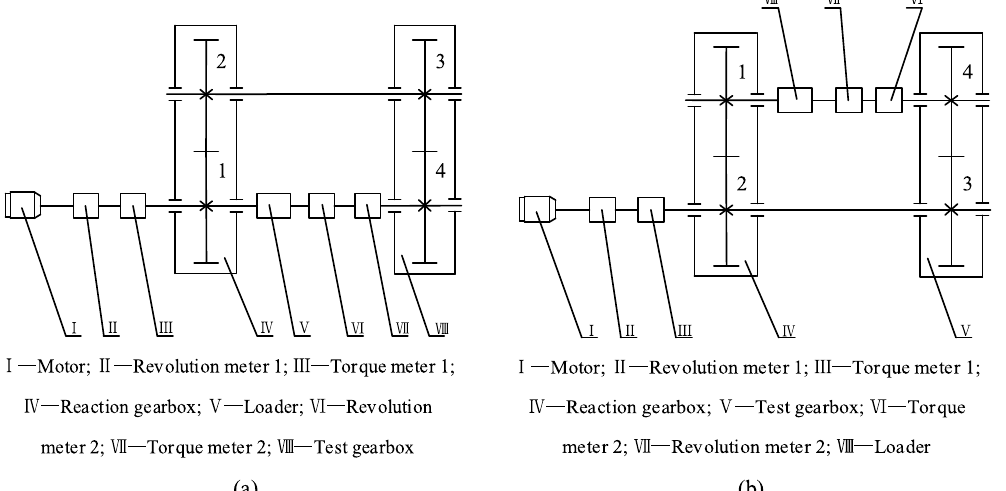
Fig. 3. Schematic diagram of gear transmission ef fi ciency test-rig with closed power fl ow. (a) Motor and loader are on the same axis (b) Motor and loader are on the different